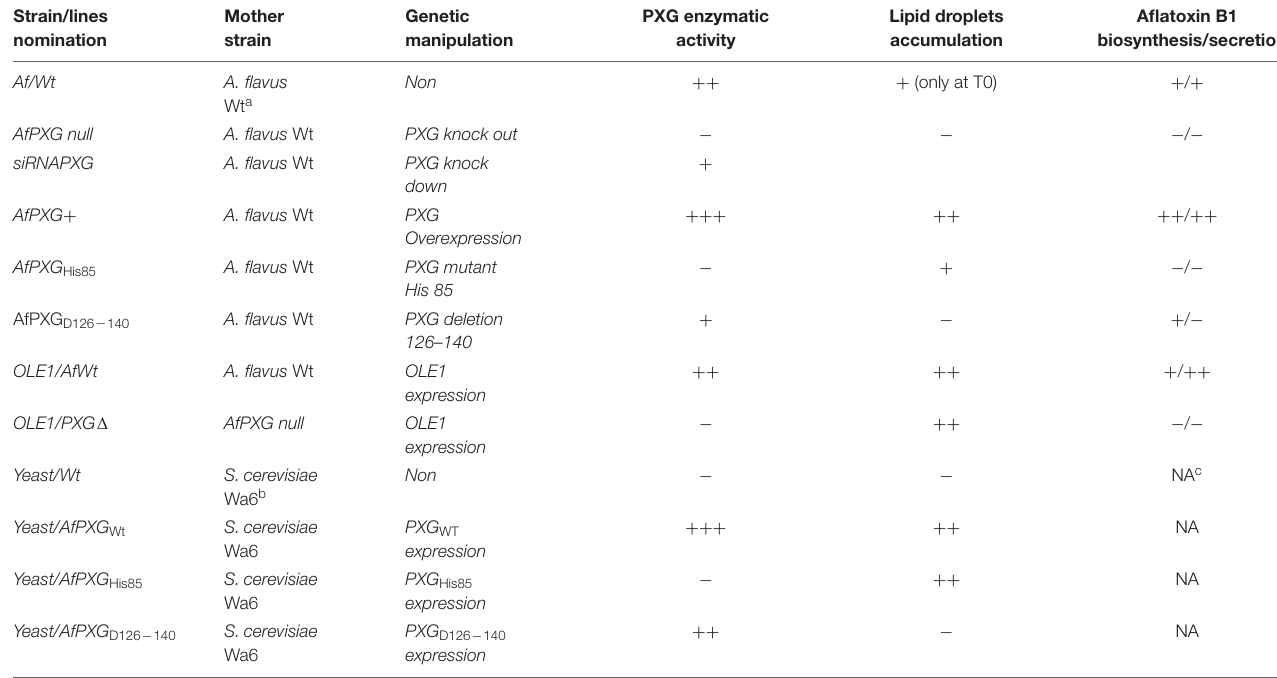
TABLE 1 | Strains and lines of Aspergillus flavus used in this